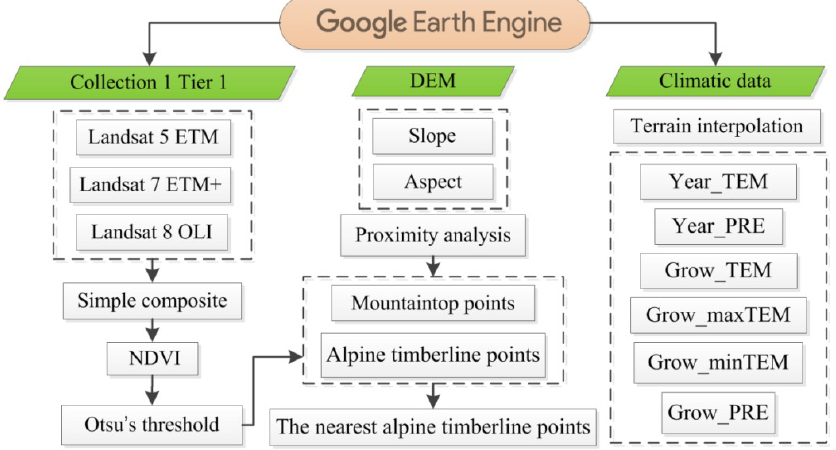
Figure 2. A flow chart demonstrating the data process.